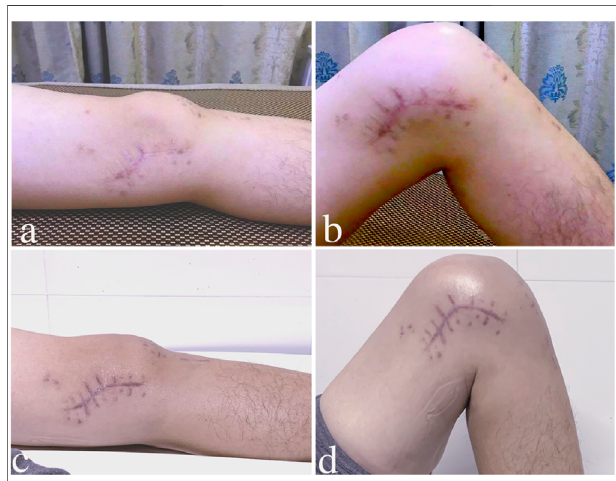
FIGURE 3 | Knee ROM at the intermediate rehabilitation and 1-year follow-up. (A,B) : subject achieved a normal knee extension and fl exion angle after the intermediate rehabilitation; (C,D) : at 1 year follow-up, the same patient ’ s knee extension and fl exion angle showed a further increase.